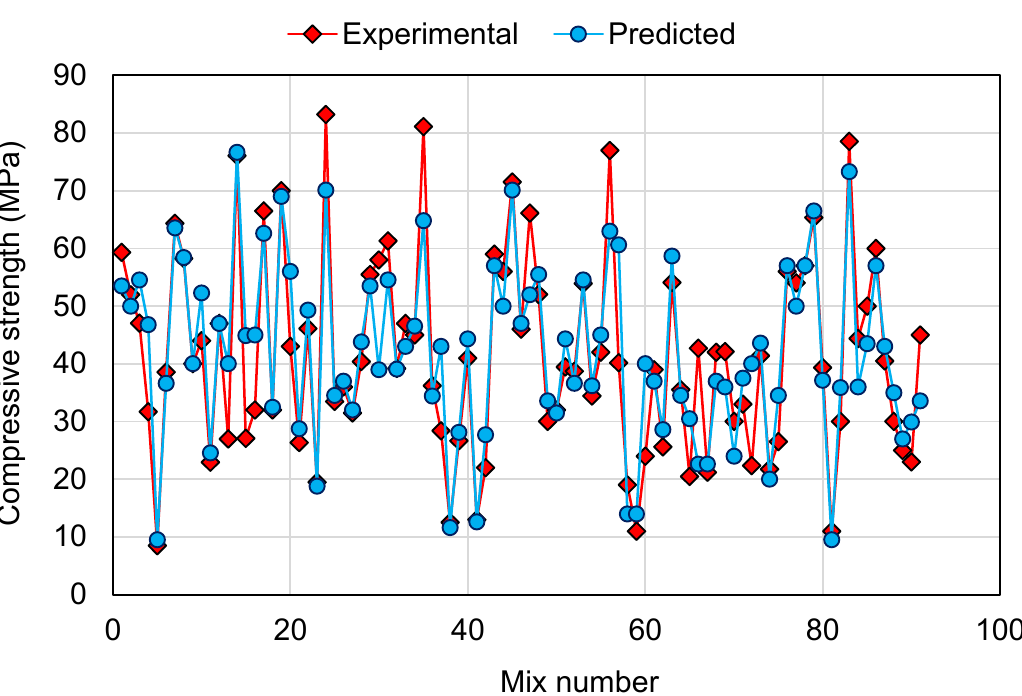
Figure 15. Comparison of experimental and predicted results for the AdaBoost model.